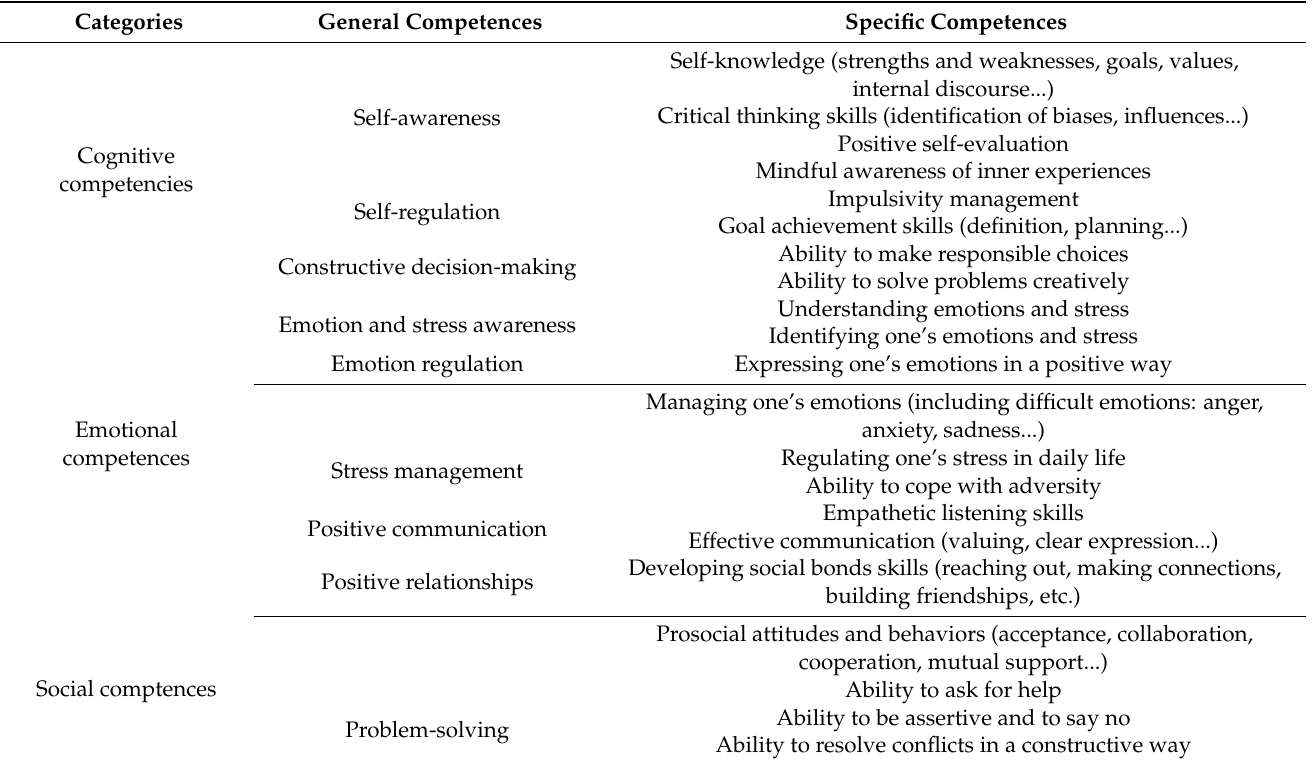
Table 2. Updated classification of PSCs (proposed by Sant é publique